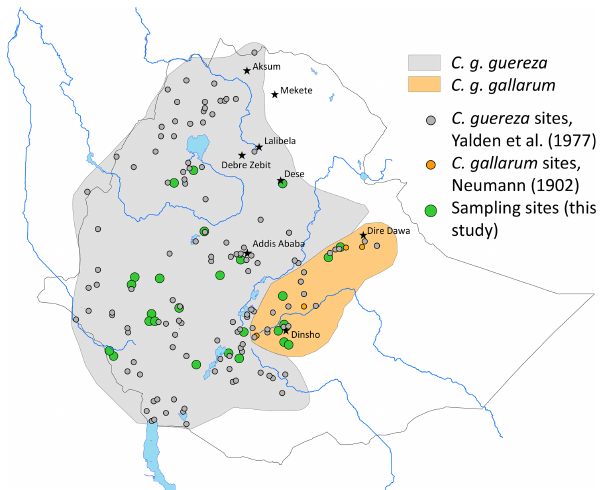
Figure 1. Approximate distribution of Colobus guereza subspecies in Ethiopia and sampling sites for genetic analysis (see also Ta- ble